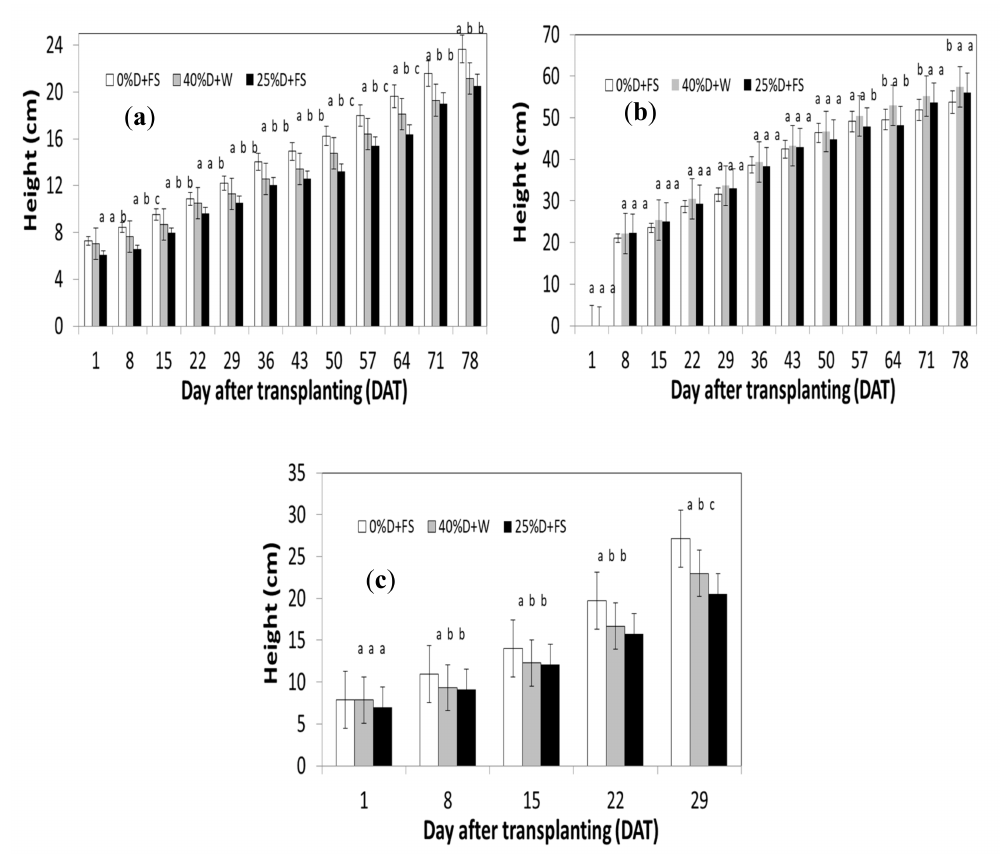
Figure 2. The mean height (cm) of the ( a ) rosemary, ( b ) basil and ( c ) peppermint during the 1st Period. The error bars represent the standard deviation of the means. Di ff erent letters within DAT indicate statistically significant di ff erences ( p <